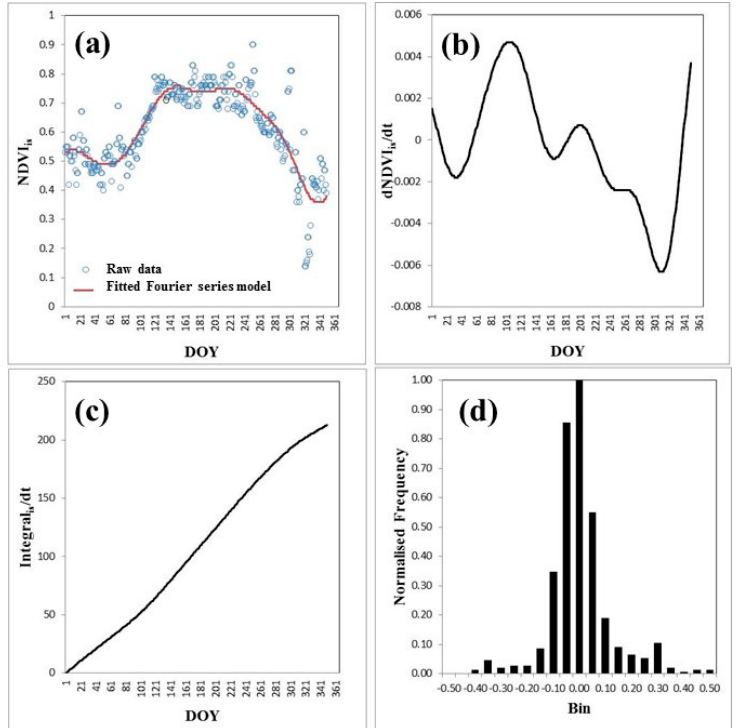
Figure 1. Example of output from an in situ normalized difference vegetation index (NDVI is ) Fourier time series (Equation (5)) for a deciduous forest site (Missouri Ozark site, USA). ( a ) NDVI is data (blue circles) and NDVI is fit (red line), ( b ) first derivative of the NDVI is time series, ( c ) integral over one year of the NDVI is time series, and ( d ) histogram of the normalized residuals of the NDVI is fit of NDVI is time series data